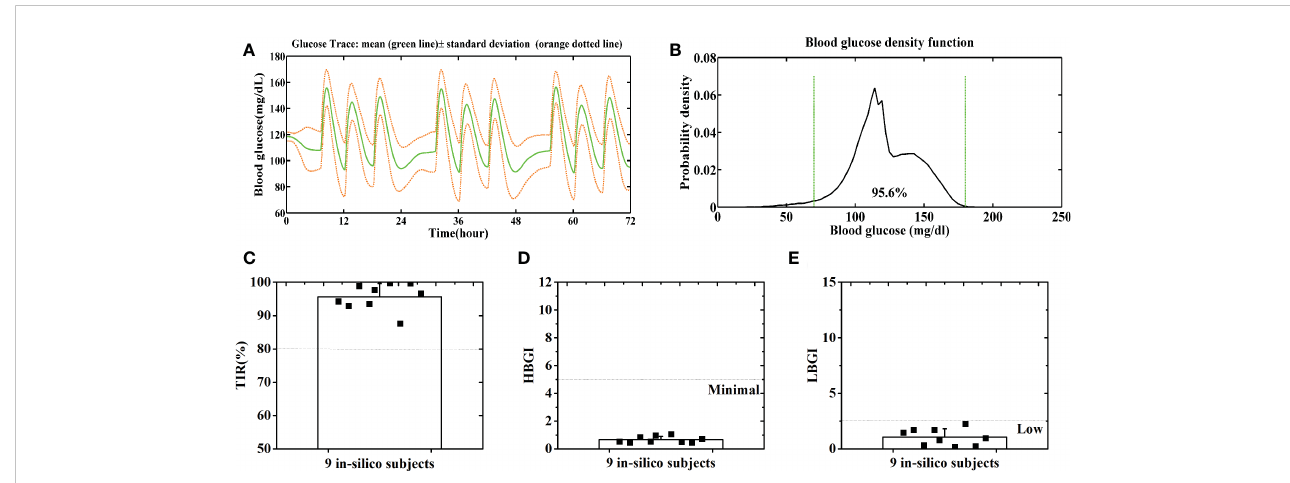
FIGURE 7 Average BG trace (A) and BG density (B) of 9 in-silico subjects with a normal CHO intake. Distributions of the TIR (C) , HBGI (D) and LBGI (E) of 9 in-silico subjects with a normal CHO intake. Green lines denote the euglycemic